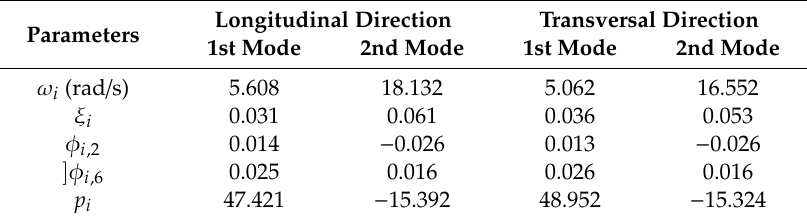
Table 2. The identified modal parameters for the building.